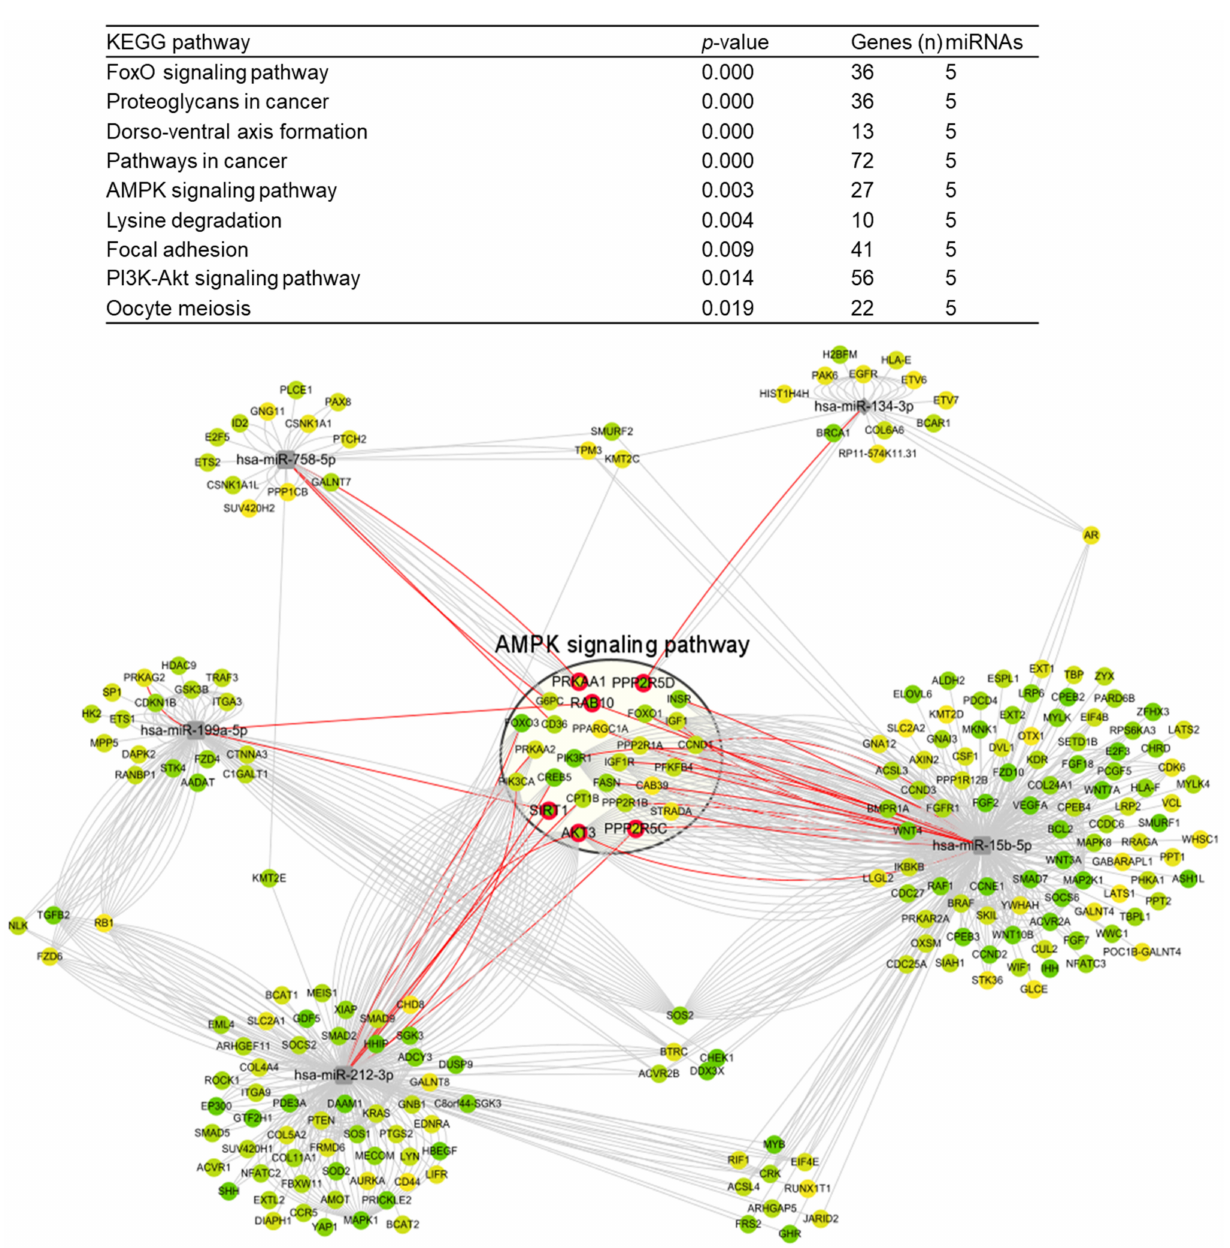
Figure 5. Pathways related to the dysregulated miRNAs in the cochlear nuclei of noise-exposed rats. Among the predicted pathways, the AMPK signaling pathway was explored for related genes based on the previous studies which reported the modulation of AMPK signaling following noise-induced hearing loss [15,16]. Each miRNA was investigated for its associated target genes of the AMPK signaling pathway (Table 1). The predicted target genes of miR-758-5p–related AMPK signaling were G6PC , PRKAA1 , and SIRT1 . The predicted target genes of miR-15b-5p, i.e., FASN , IGF1R , PPP2R5C , CCND1 , PPP2R1A , PIK3R1 , INSR , and IGF1 , were related to AMPK signaling. The predicted target genes of miR-212-3p, i.e., PPP2R5C , AKT3 , PIK3CA , FOXO3 , and CPT1B , were related to AMPK signaling. The predicted target genes of miR-199a-5p, i.e., PRKAG2 , RAB10 , PRKAA2 , SIRT1 , CREB2 , and PPP2R5C , were involved in AMPK signaling. The predicted target gene of miR-134-3p was PPP2R5D